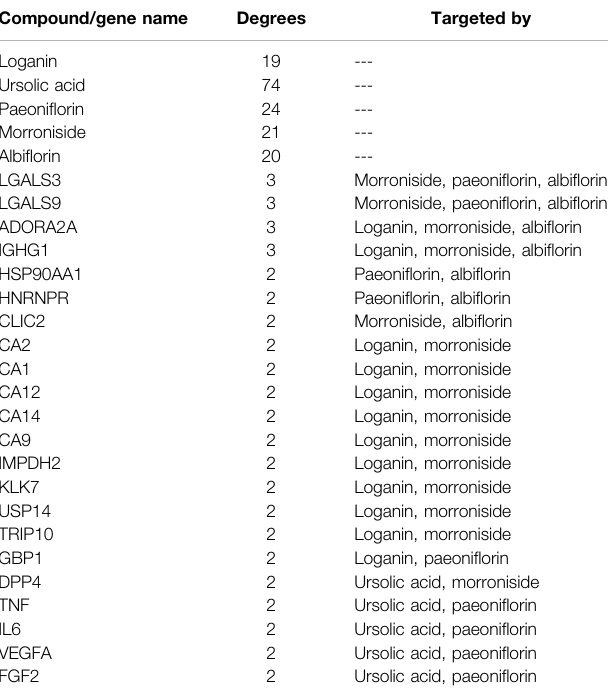
TABLE 4 | Degreesof freedoms of genes targeted bymultiple active compounds. Compound/gene